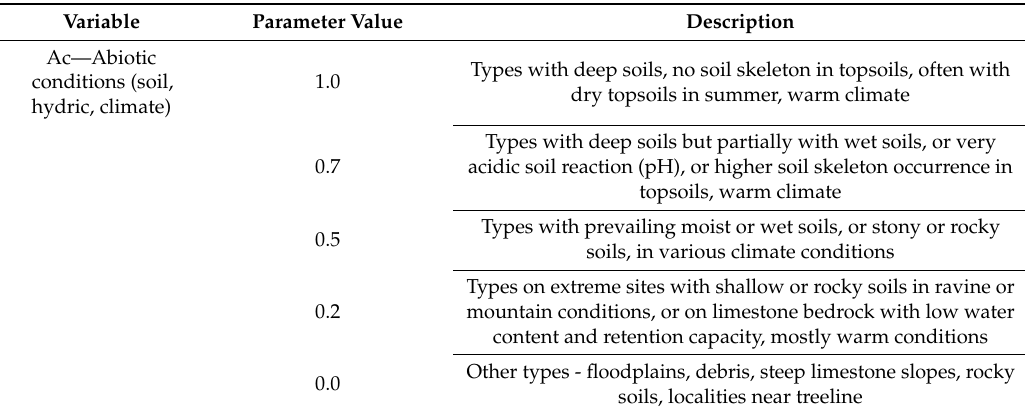
Table 1. List of variables and their parameters applied in the assessment of the forest stands potential for ectomycorrhizal mushrooms